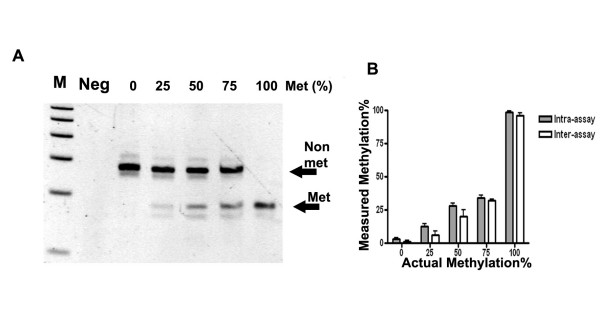
Intra- and inter-assay variation of the duplex MSP. (A) Duplex MSP of a mixture of CCNA1 complete and non-methylated CC cell lines, SiHa and HeLa(S), respectively. M, DNA size marker; Neg, negative; 0, 25, 50, 75, 100 Met (%) represent the proportion of SiHa DNA in the mixture, varied from 0 to 100%, respectively. The upper and lower bands are non-methylated and methylated bands, respectively, indicated by labeled arrows. (B) Graphical comparison between measured CCNA1 methylation, percentage intensity of methylation amplicon (x-axis), and actual methylation, the proportion of SiHa DNA (y-axis). The bar height indicates the mean and error bars, T, represent standard deviation (SD) across experiments.